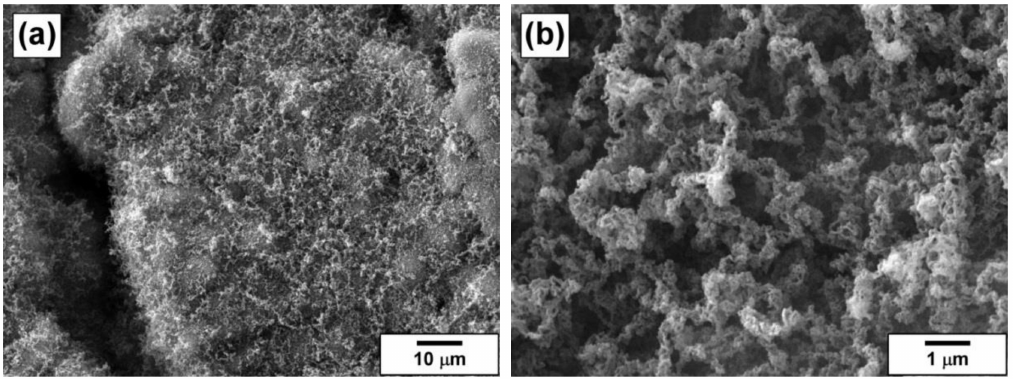
Figure 6. SEM images of the carbon product obtained via CCVD of 1,2-dichloroethane over the Ni-Mo-Mg-O catalyst at various magnifications: ( a ) × 1,000 and ( b ) ×